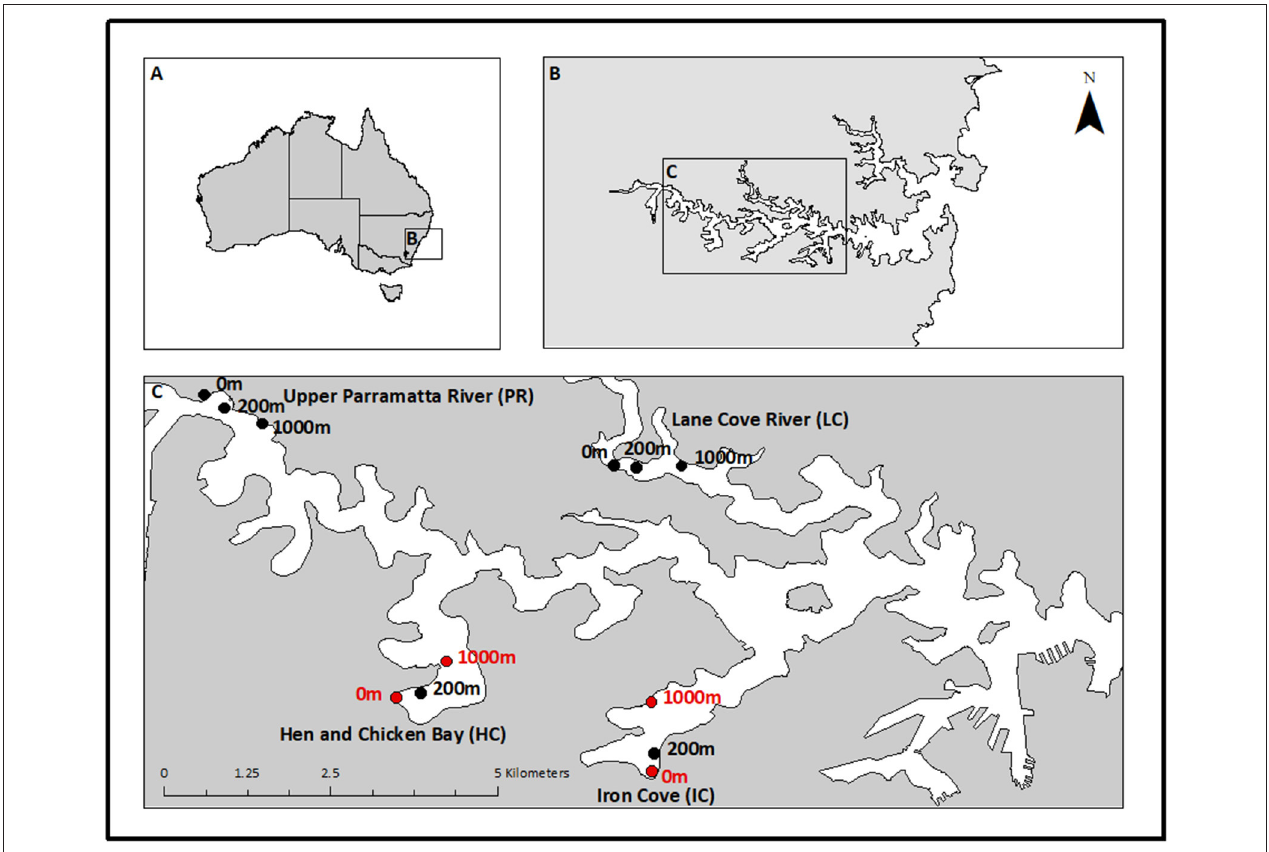
FIGURE 1 | Sampling locations in Sydney Harbour, New South Wales, Australia. Map shows (A) Australia, (B) Sydney Harbour estuary, and (C) locations sampled within the estuary. The Upper Parramatta River (100 km 2 ; PR) and Lane Cove River (80 km 2 ; LC) locations are well flushed channels with low retention. The embayments Hen and Chicken Bay ( < 10 km 2 ; HC) and Iron Cove (14 km 2 ; IC) experience very little flushing and were therefore selected as high retention sites. Samples were taken monthly from February to May 2014. Sampling sites within each location ( n = 3) are indicated by approximate proximity to a large storm drain (i.e., 0, 200, 1,000m). Sites highlighted in red were selected for metatranscriptomics analysis (collected in February and March).